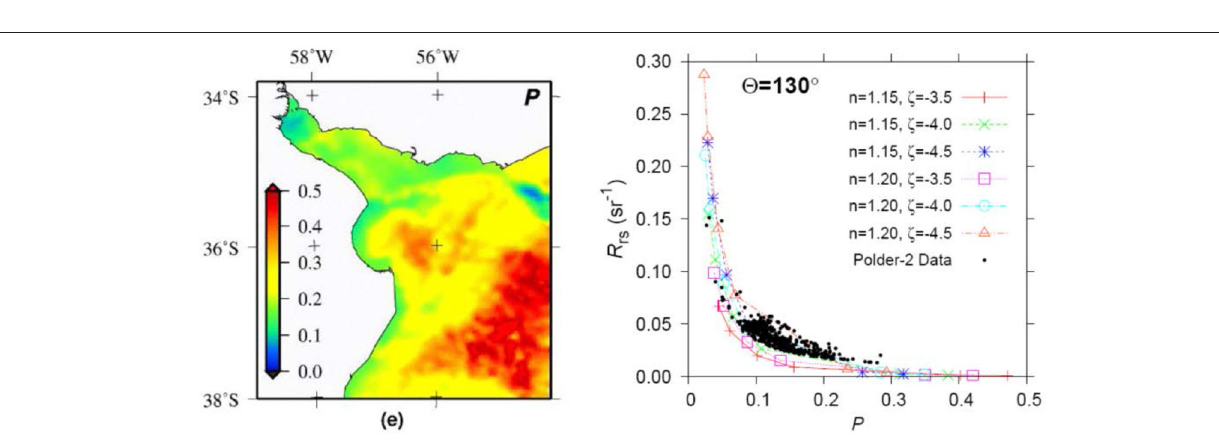
polarimeters that measures light at 3 visible and 1 NIR